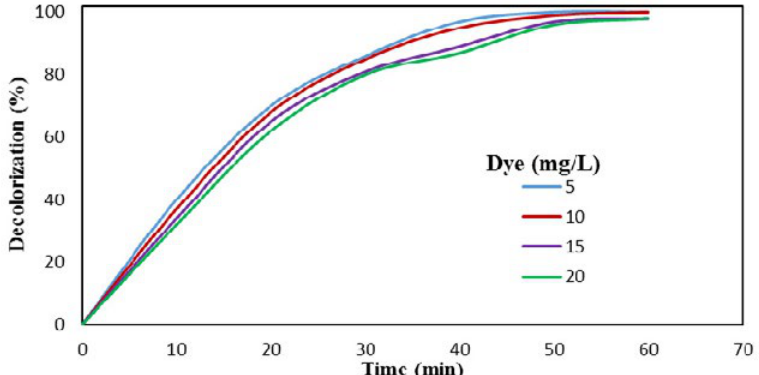
Fig. 5. Effect of initial concentration of MG dye on the decolorization efficiency (%).